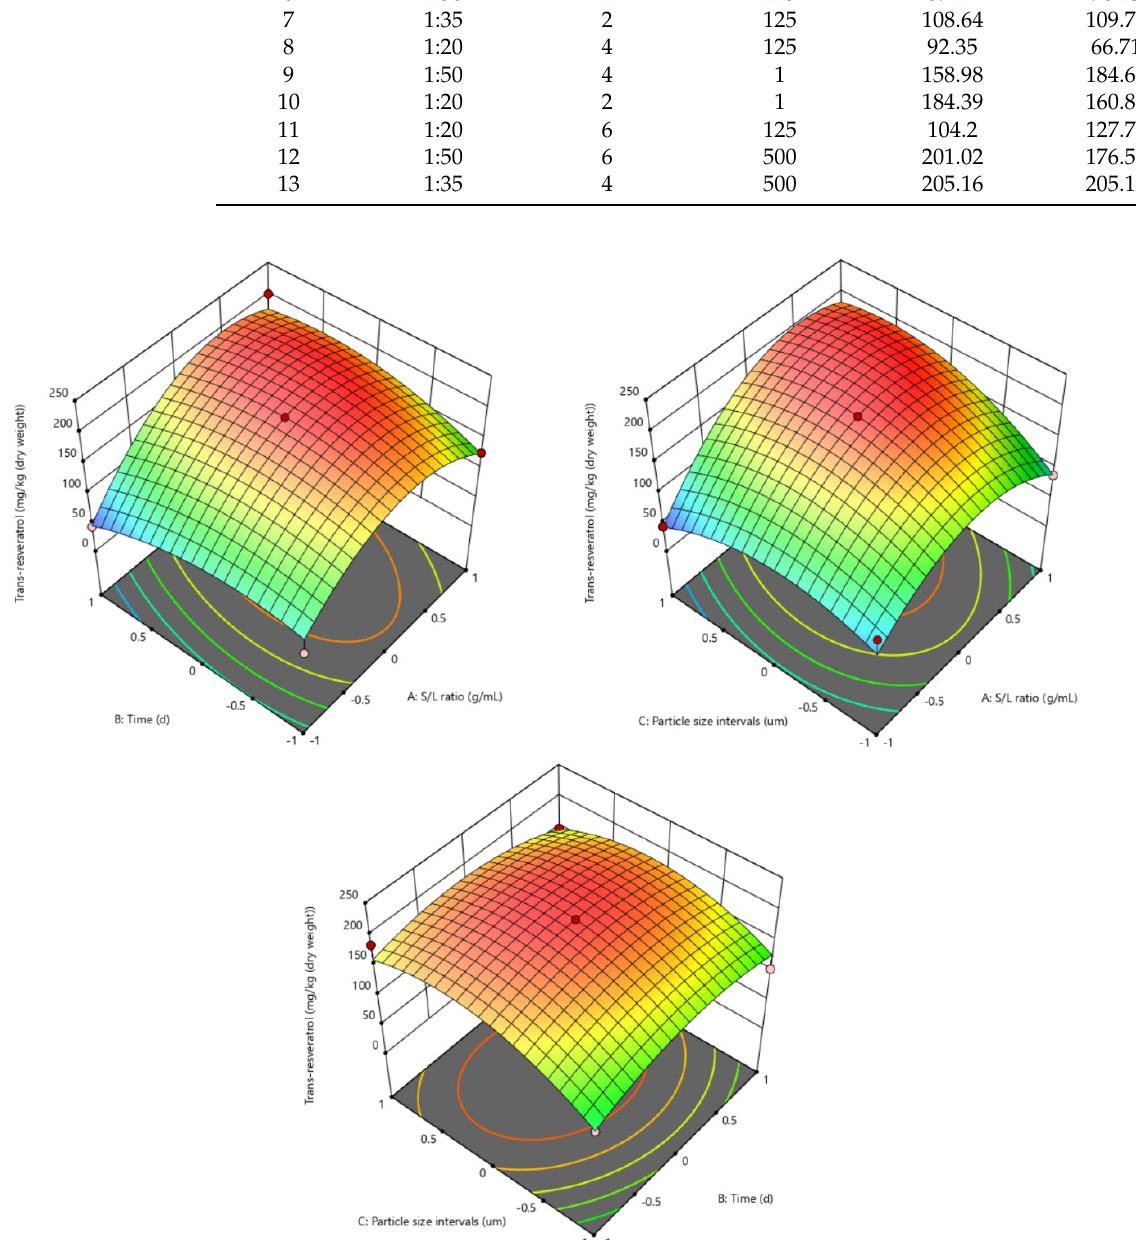
Figure 7. Three-dimensional graphs of trans-resveratrol content evolution after extraction with ethanol:diethyl ether 4:1 ratio.